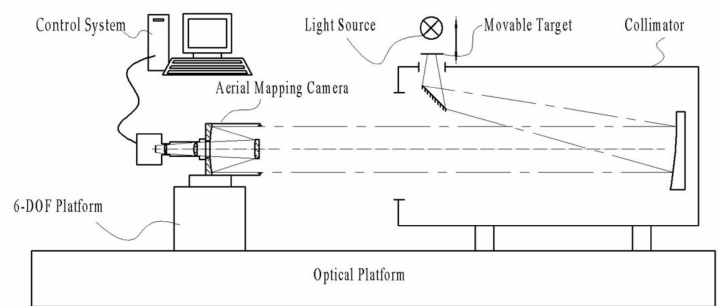
Figure 10. Pixel resolution experiment platform of the mapping camera.